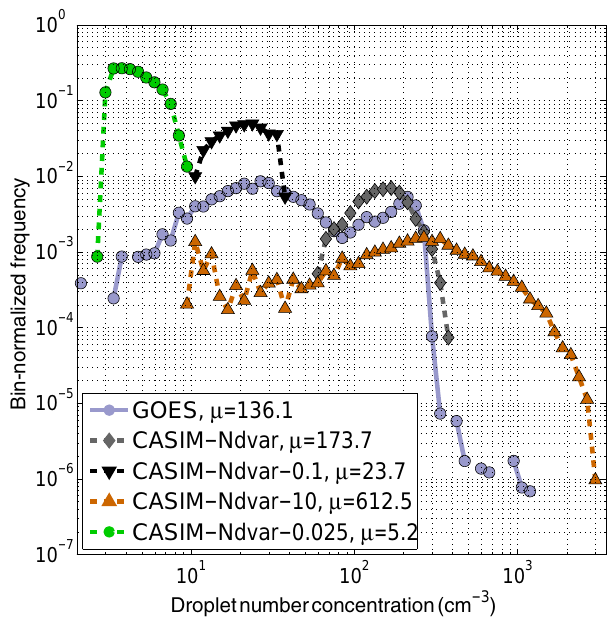
Figure 3. PDFs of the cloud droplet number concentration for the model domain region. A snapshot time of 14:12LST on 13 Novem- ber is used for the model and 13:57LST for the GOES-10 satellite, which is the nearest available data point. Three-dimensional model data are first converted to 2-D data, taking the N d at the height of the maximum LWC with each model profile. The model data are subse- quently coarse-grained from their native 1km resolution to that of GOES-10 (4km). Data points from both the model and the satellite are ignored if the LWP is less than 5gm − 2